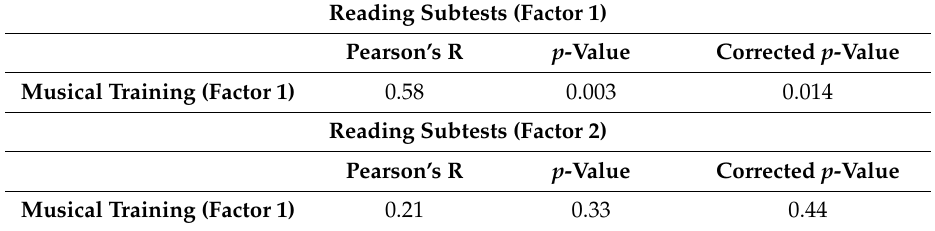
Table 10. Relations between Musical Training (MT) History and Reading Tests. Pearson’s R computed musical training and reading factors derived from PCA. Here, musical training factor 1 reflected a global measure of musical experience. Reading factor 1 largely reflected rapid-naming skills, while reading factor 2 primarily reflected phonological-awareness skills. The correlations are presented with corrected probability values using the Benjamini & Hochberg (BH) correction to control the false discovery rate